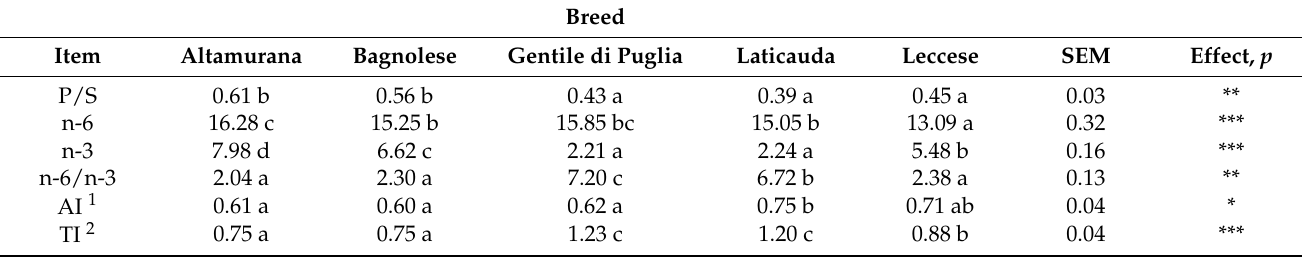
Table 4. Intramuscular conjugated linoleic acid CLA content (g/100 g fatty acid methyl esters) and nutritional indices of Longissimus lumborum (LL) of lambs from five sheep breeds reared in continental Southern Italy (means ±